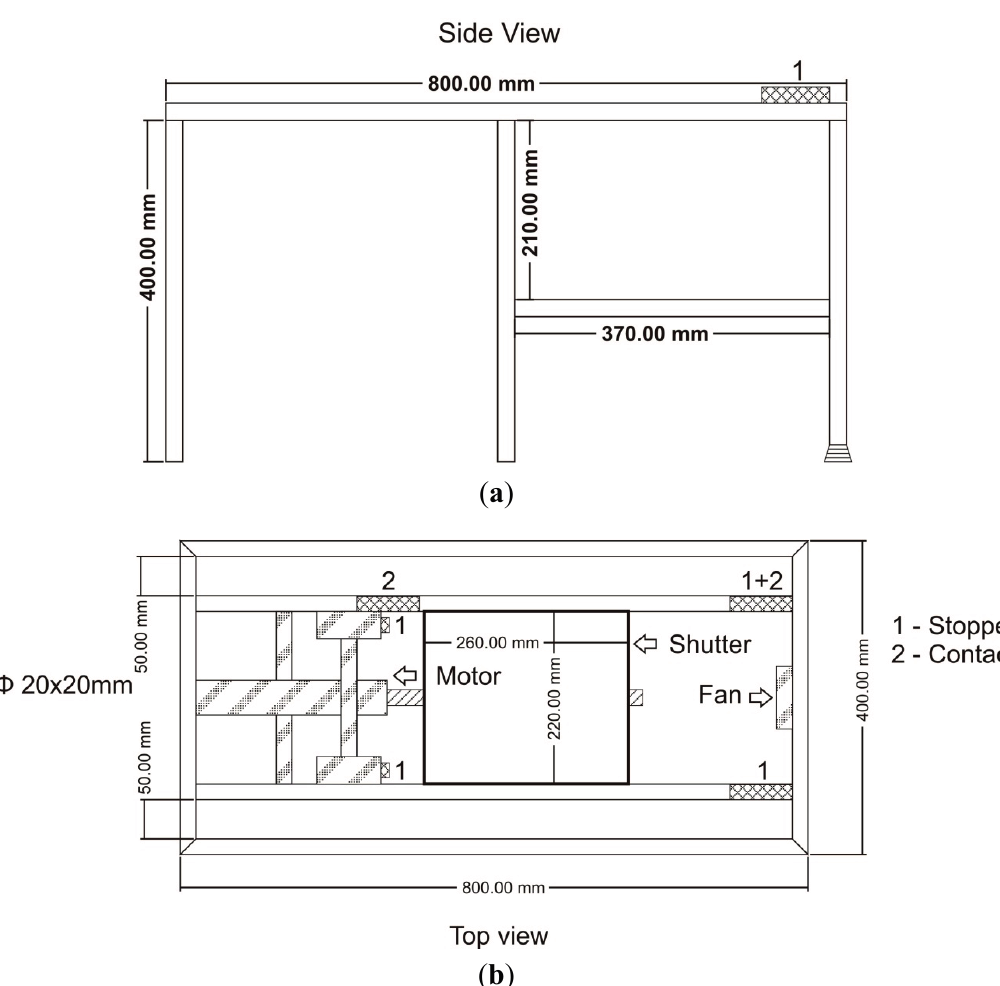
FBGs: 1—mechanical stops; 2—limiting switches. ( d , e ) the practical implementation of the